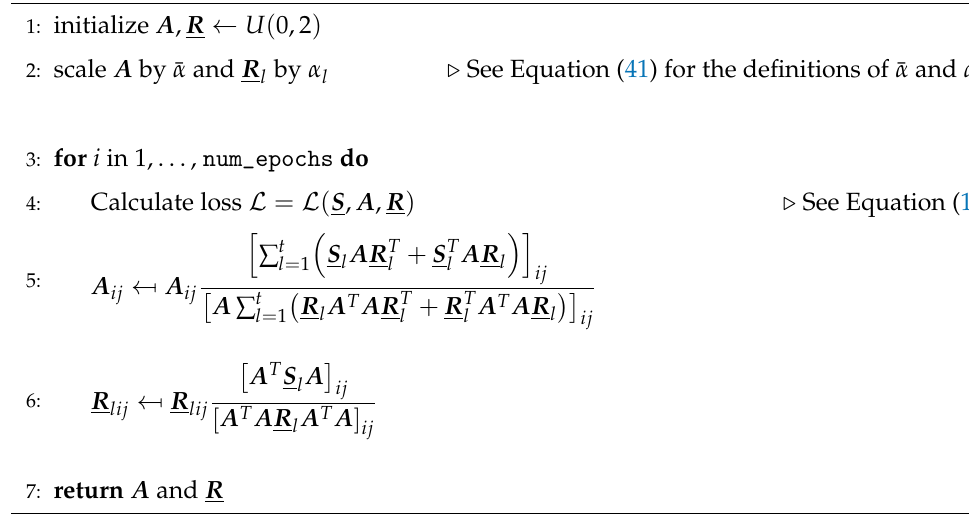
Algorithm 2 The non-negative tensor DEDICOM